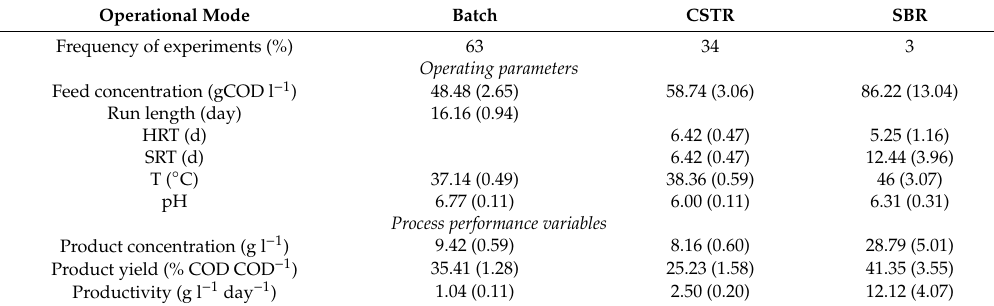
Table 4. Mean value and standard error (in brackets) of operational and performance parameters grouped by operational